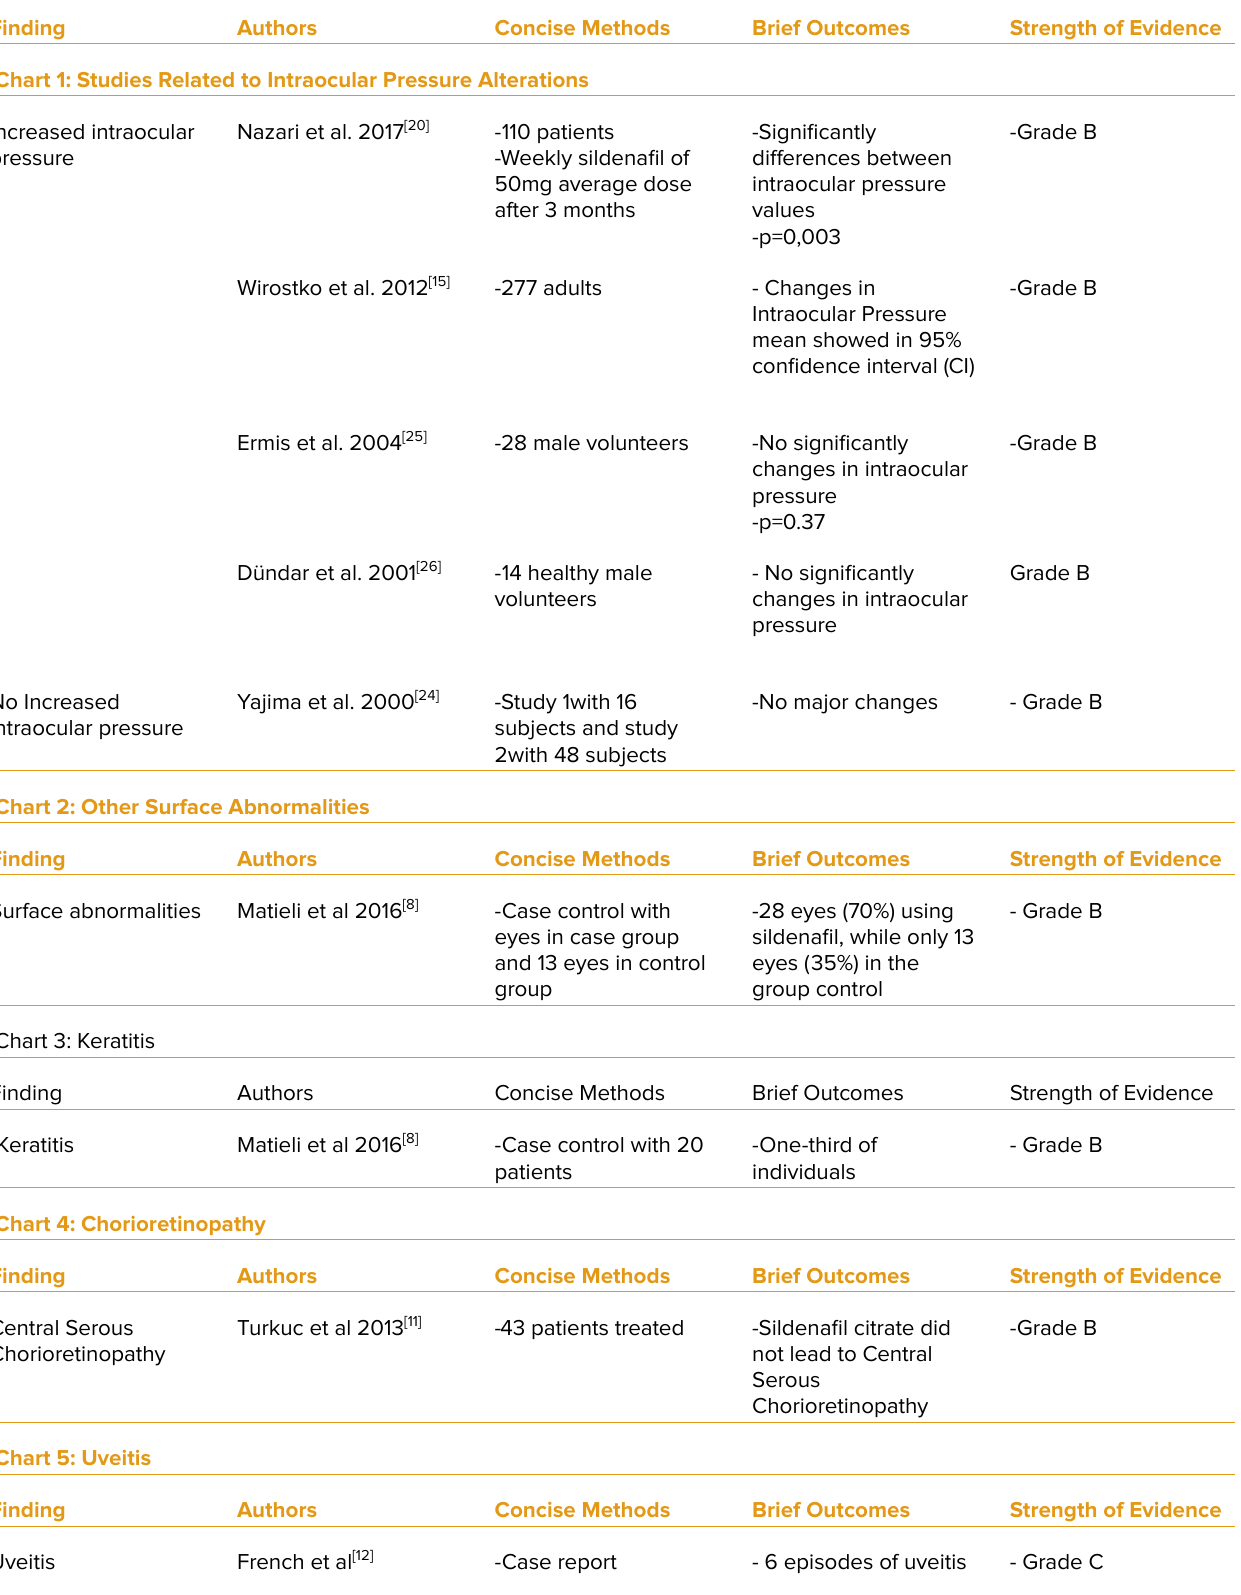
Table 1. The best studies for each category Finding Chart 1: Studies Related to Intraocular Pressure